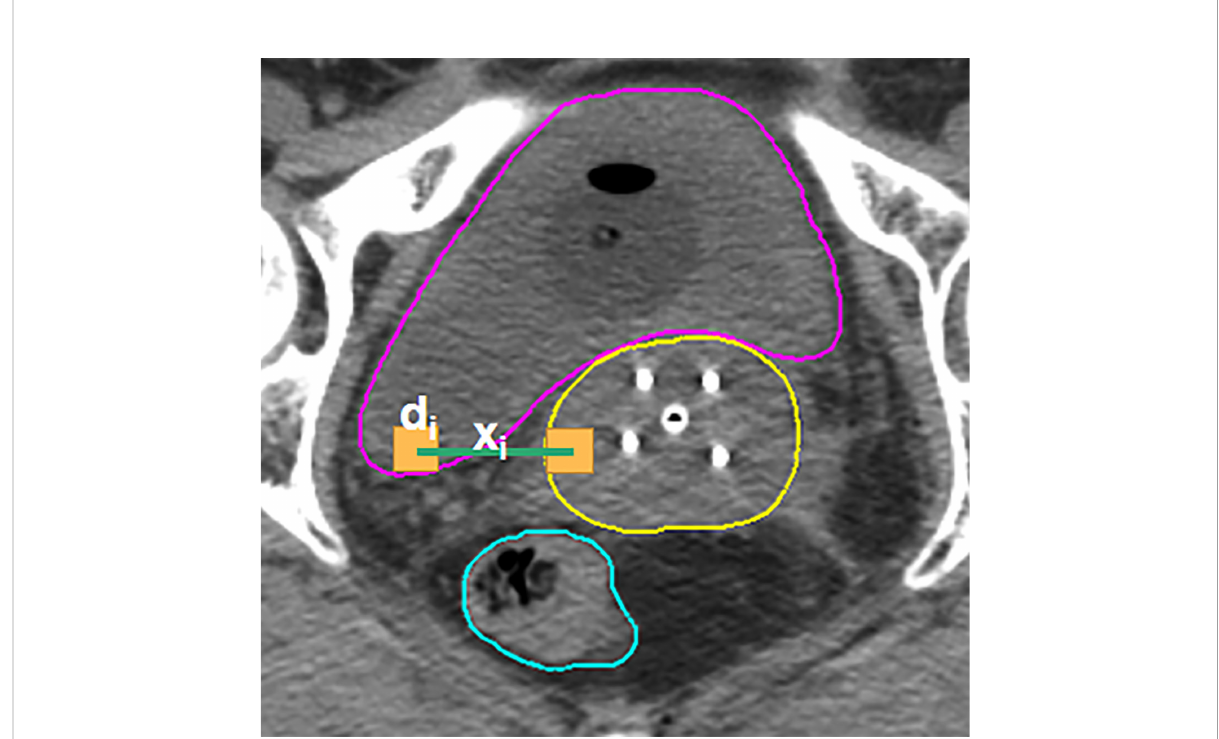
FIGURE 3 Illustration of the KDE method in the brachytherapy treatment planning. For each voxel in the OAR, xi is the distance between this voxel and its closest voxel on the HRCTV surface and di is the dose received in each voxel inside the